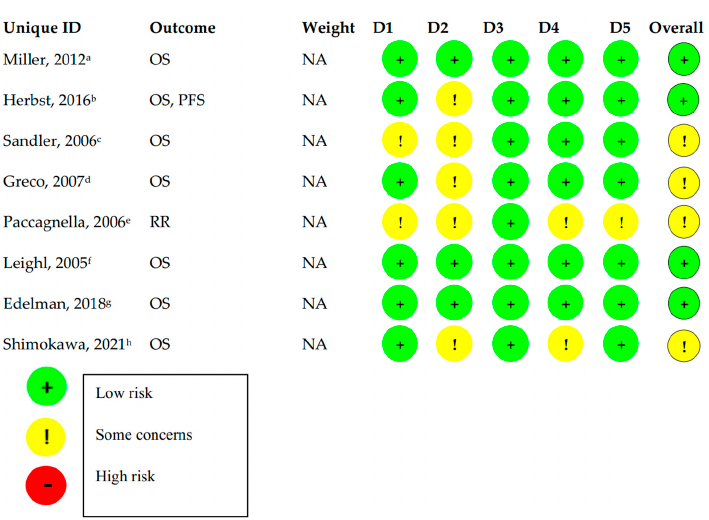
Figure 2. Risk of Bias Assessment on all completed trials using the Cochrane risk-of-bias tool for randomized trials (RoB 2). OS: overall survival; PFS: progression-free survival; RR: response rate; NA: not applicable; a [14], b [31], c [15], d [18], e [16], f [23], g [32], h